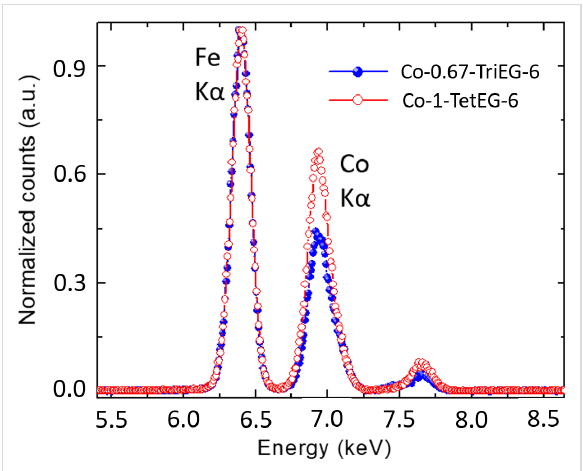
Figure 2: X-ray fluorescence experiments performed on two represen- tative samples, Co-1-TetEG-6 and Co-0.67-TriEG-6.